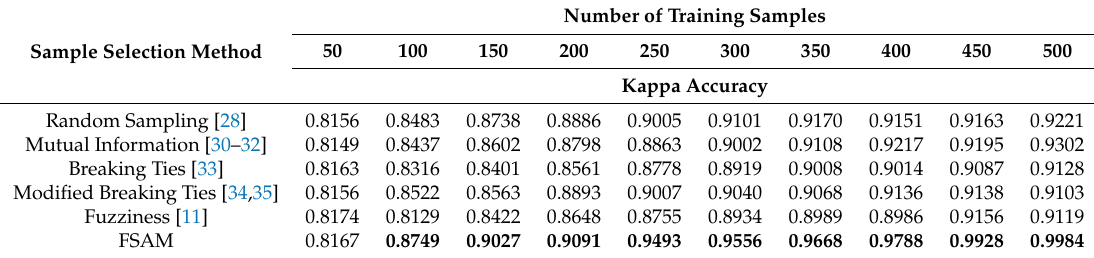
Table 4. Kappa ( κ ) accuracy obtained by SVM Classifier with different number of training samples selected in each iteration from Botswana dataset with different sample selection methods from literature.